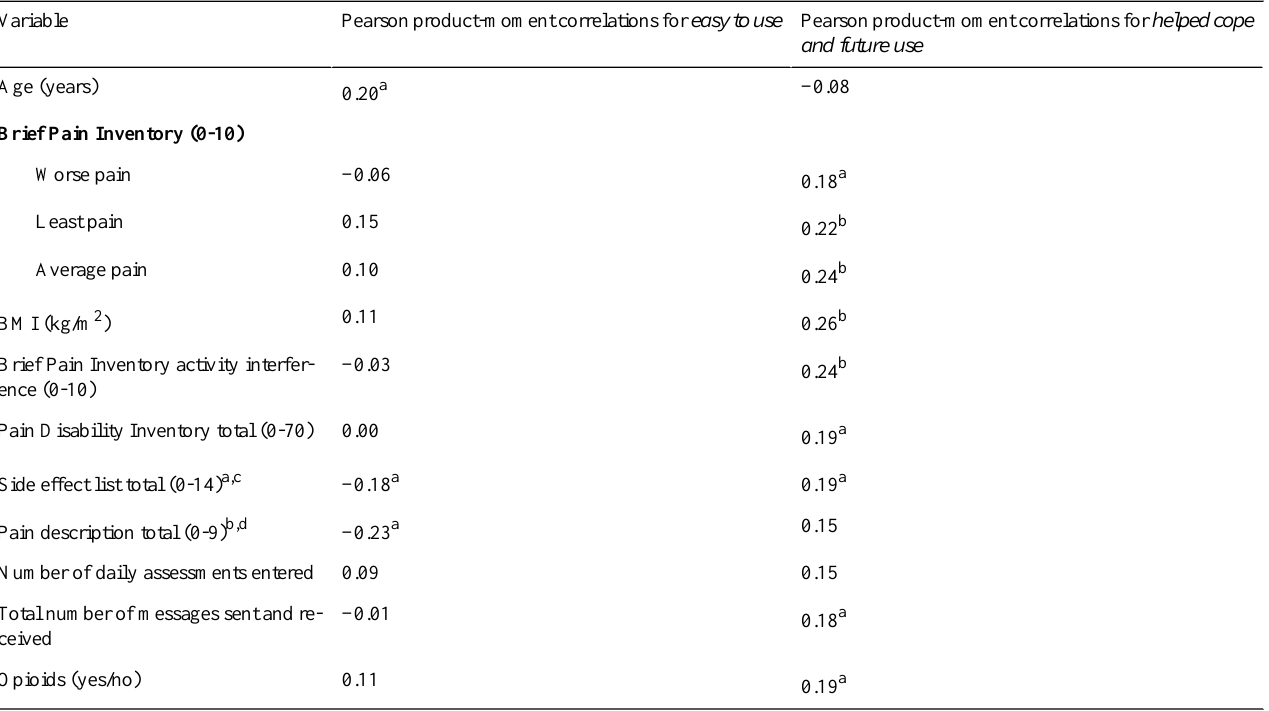
Table 2. Pearson product-moment correlations among patient satisfaction questionnaire responses between those who found the pain app easy to use, and those who felt that the app helped them to cope and would be willing to use the pain app in the future (0=very satisfied; 10=very unsatisfied). Pearson product-moment correlations for helped